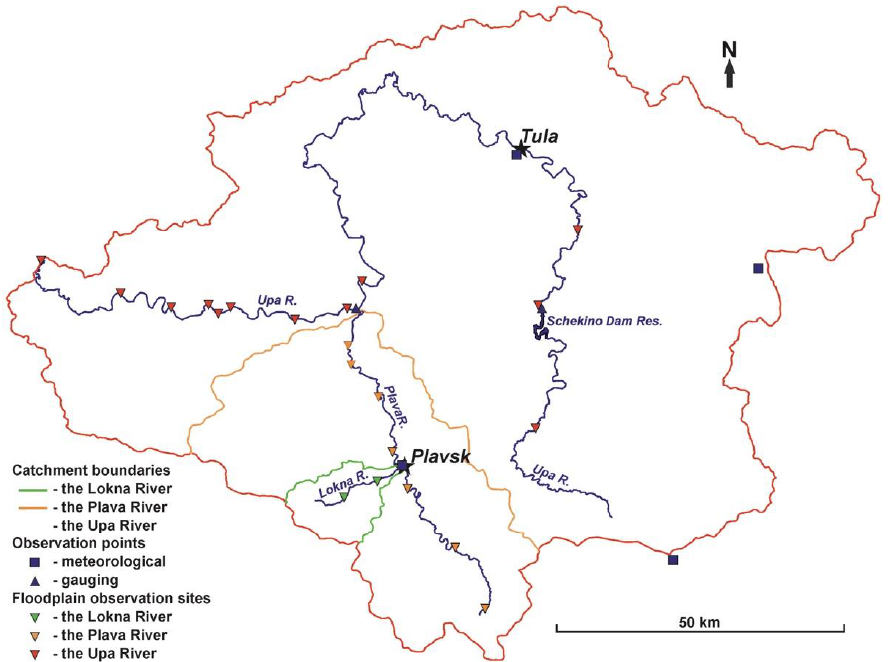
Figure 4. Locations of observation sites on floodplains of Lokna, Plava, and Upa Rivers and Schekino Reservoir.